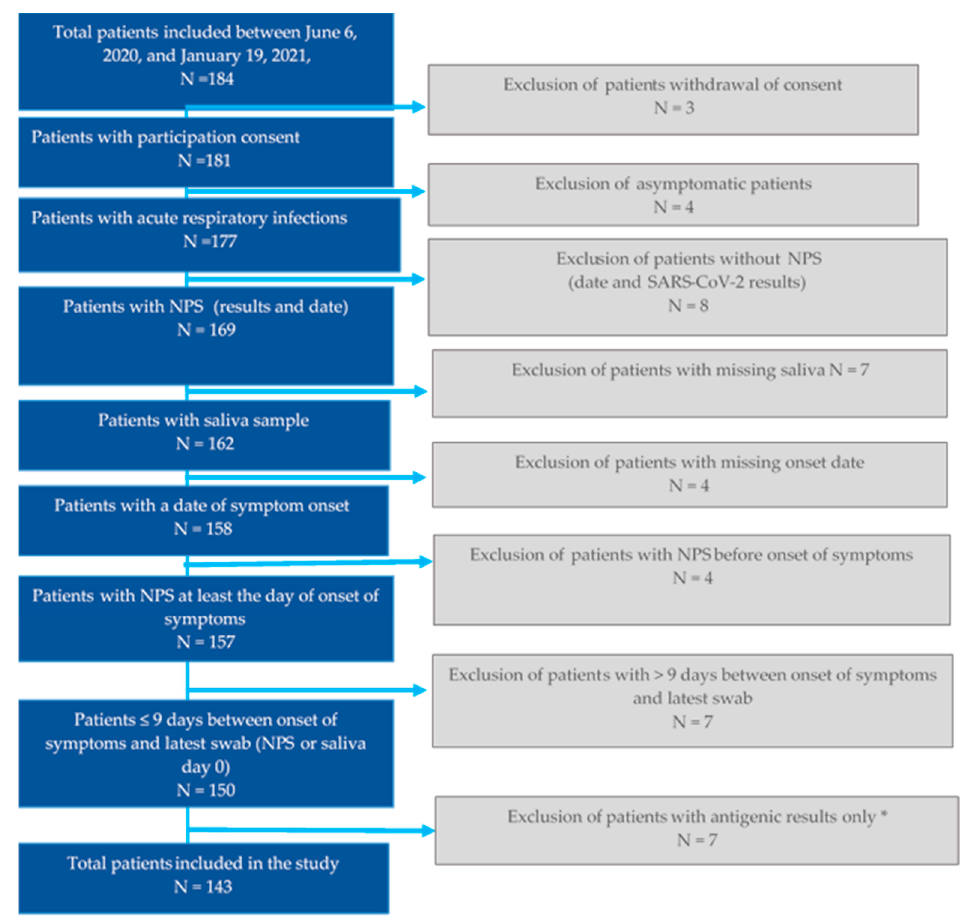
Figure 1. Flowchart of analysis of patients with ARI. * Patients tested with antigenic assay alone, were excluded as we compared paired-samples (NP and saliva) tested at a minimum by RT–qPCR. Table 1. Characteristics of patients with ARI included by the Sentinelles physicians.